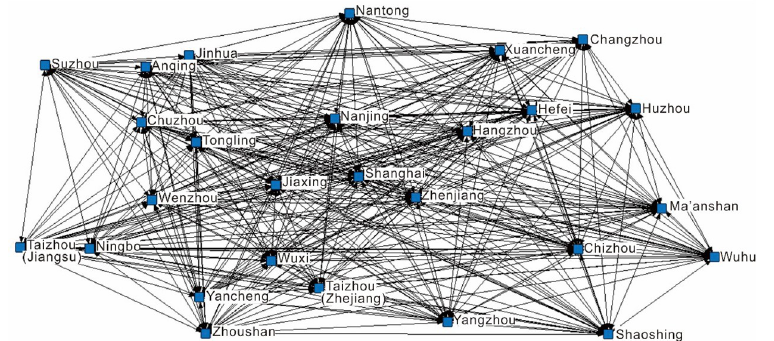
Fig 2. The supply network of regional tourism cooperation in the Yangtze River Delta.